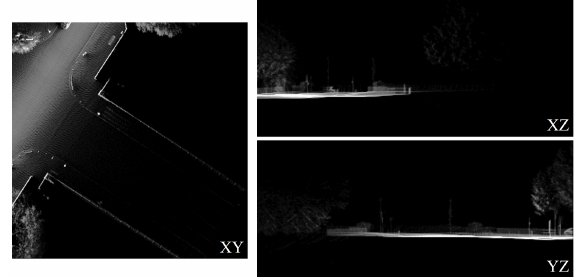
Figure 6. The three images produced from the point cloud set of Figure 1a illustrating density values.